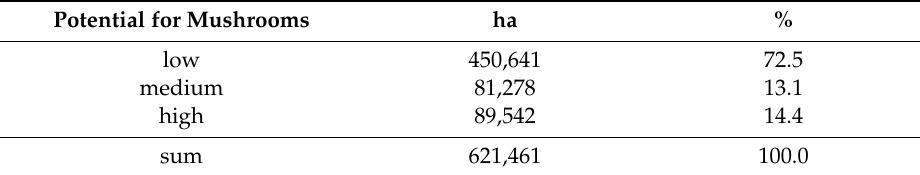
Table 2. Potential of forest stands for ectomycorrhizal mushrooms growing.